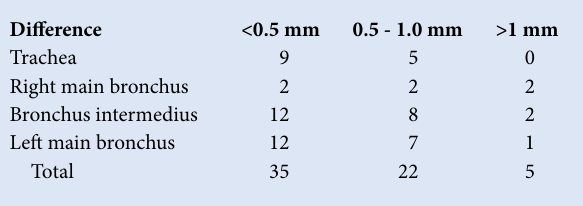
Graph 5. Comparison between measurements in soft tissue and lung windows in the trachea.